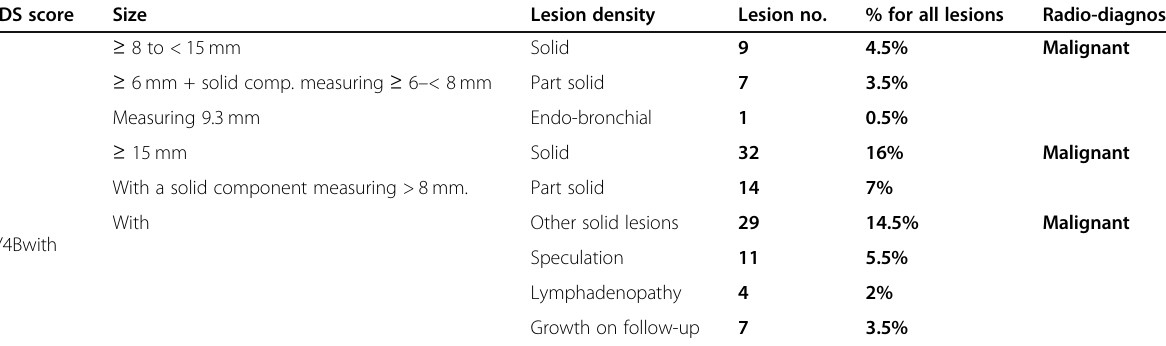
Table 5 Categorization of malignant lung nodules (lung-RADS score: 4A, B, and X). “ Group II ” (no. = 114 nodules) RADS score Size Lesion density Lesion no. % for all lesions Radio-diagnosis Solid